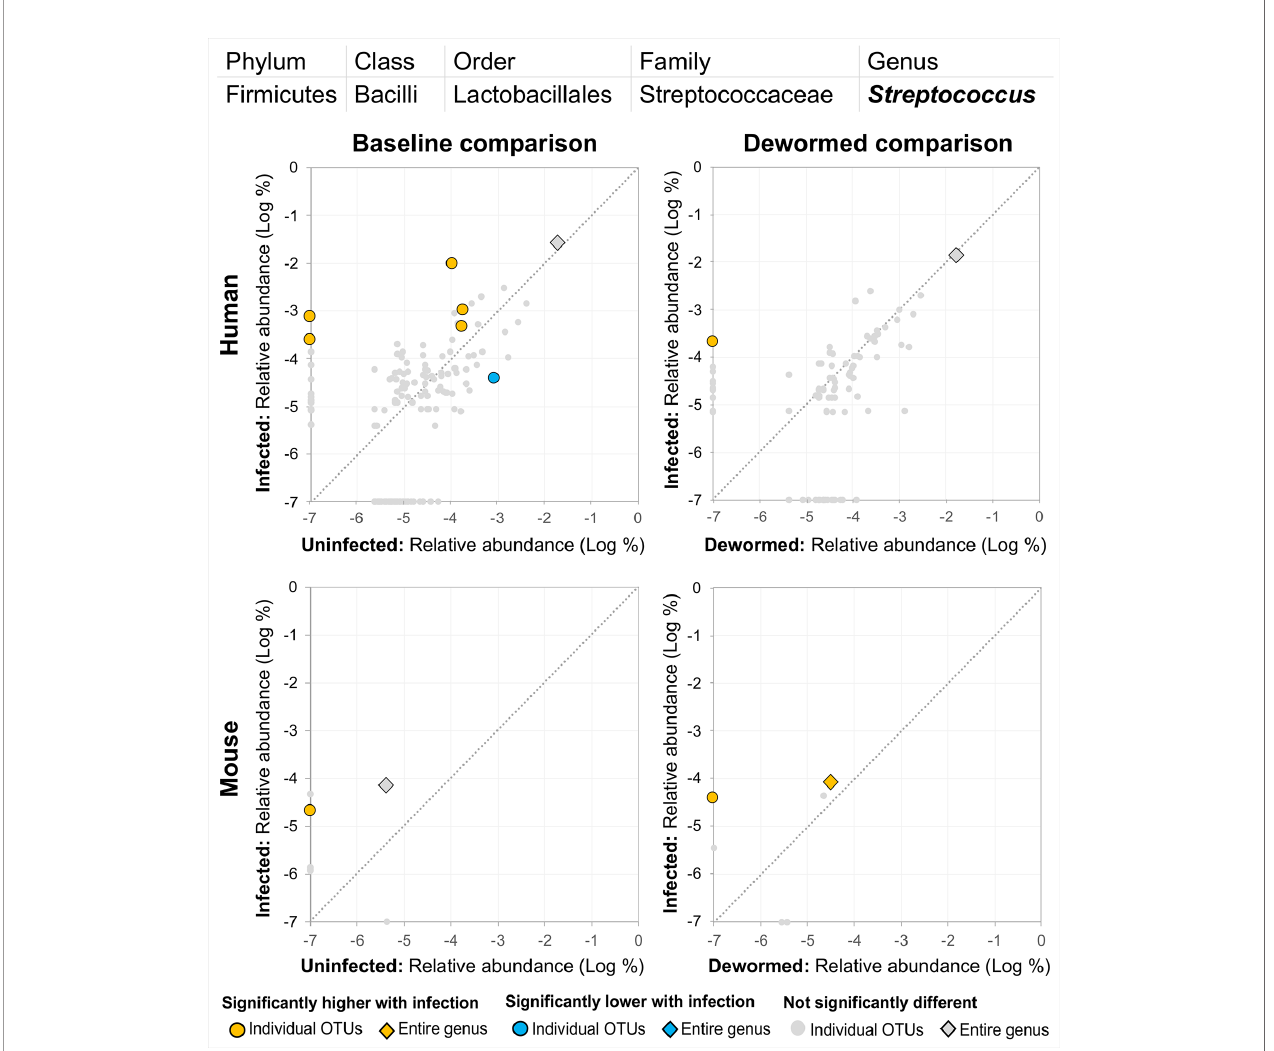
FIGURE 7 | The relative abundance (%) of all Streptococcus (genus) OTUs in each differential comparison among samples from whipworm-infected and uninfected humans and mice. Signi fi cant differentially abundant OTUs in each comparison (as identi fi ed by LEfSe) are colored in orange (higher with infection) and blue (lower with infection). The sum of all OTUs in the genus is represented with a diamond symbol. This is one of four genera with at least one OTU signi fi cantly higher in infection in all four